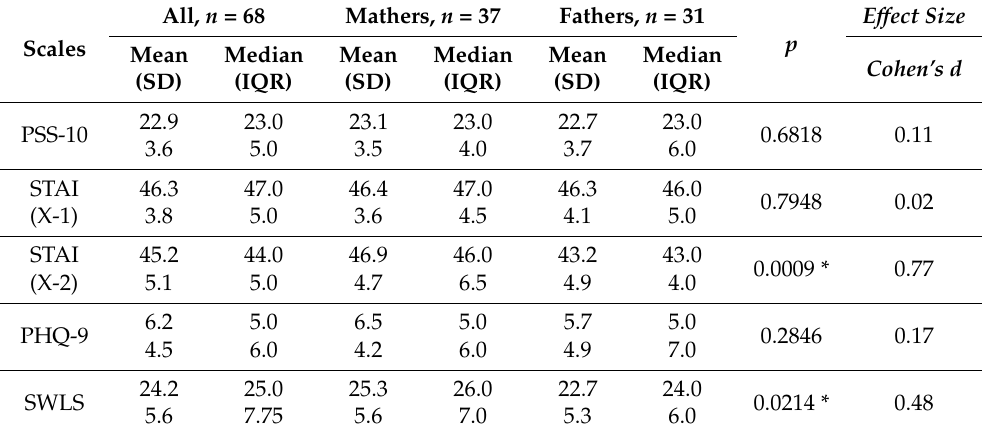
Table 2. Results of the studied parameters in the whole study group and according to sex (Mann– Whitney U test).